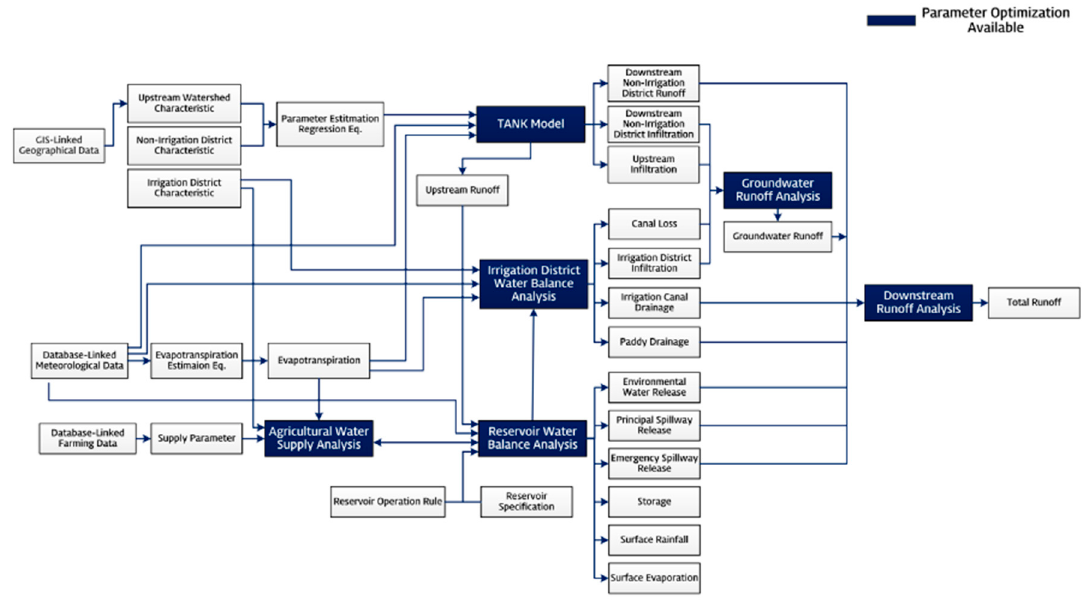
Figure 3. Flow diagram: COMFARM ‐ based modeling system with major linkable components developed in this study for agricultural water ‐ cycle analysis at the watershed scale.